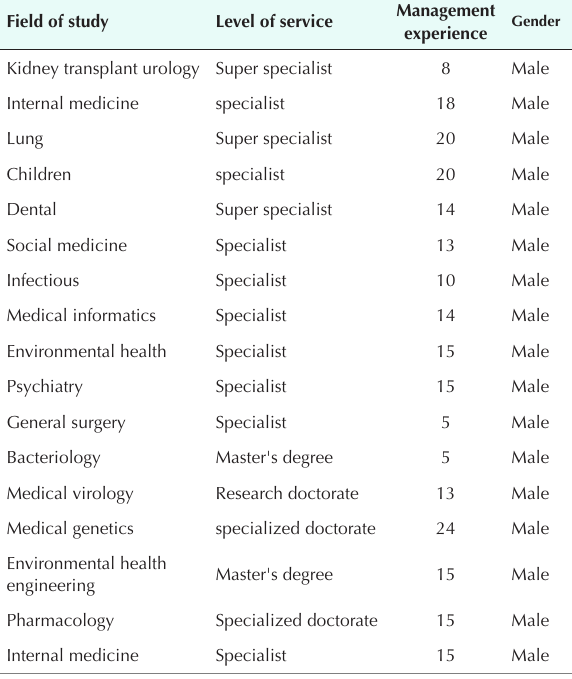
Table 1. Characteristics of the